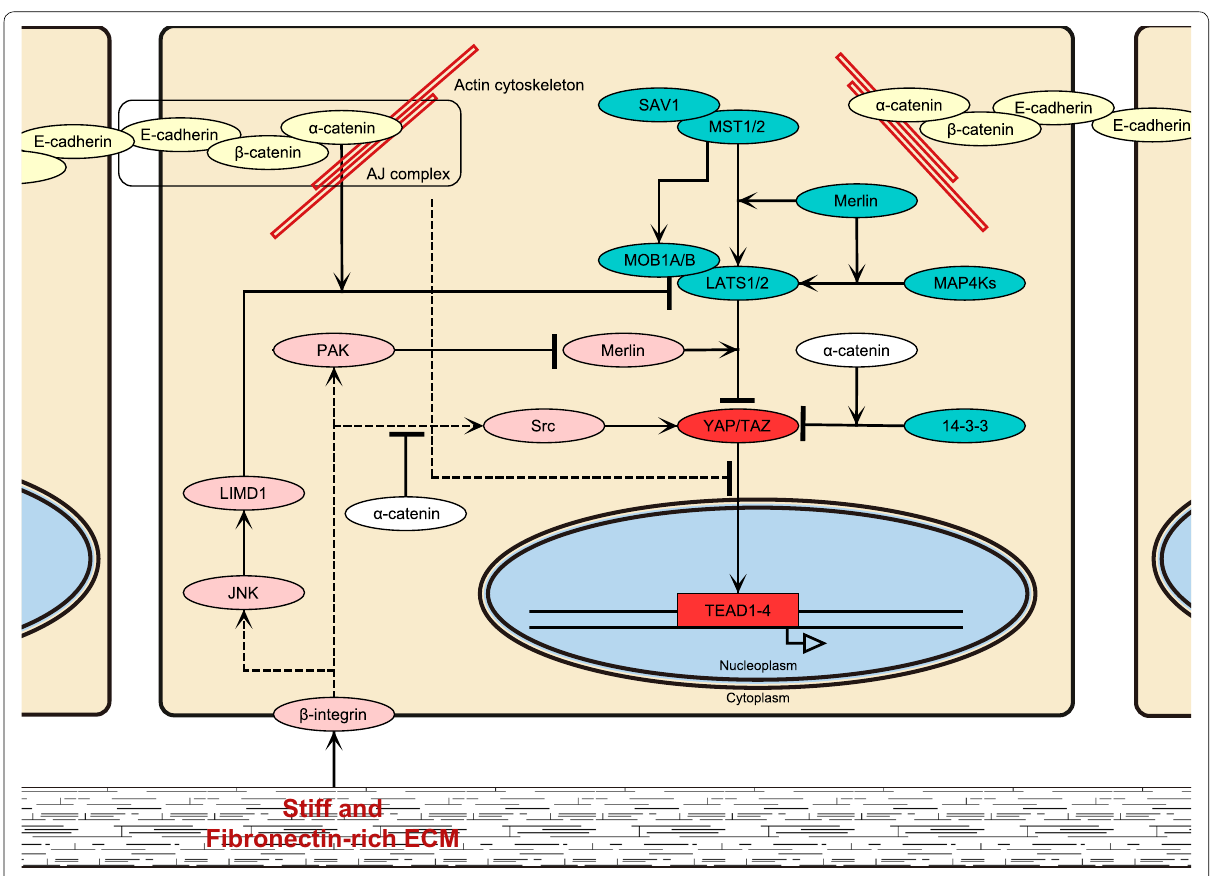
Fig. 2 Overview of signaling cascades for YAP/TAZ regulation. Hippo pathway- (blue), FA- (pink) and AJ-mediated (yellow) regulations of YAP/TAZ are shown. See the main text for